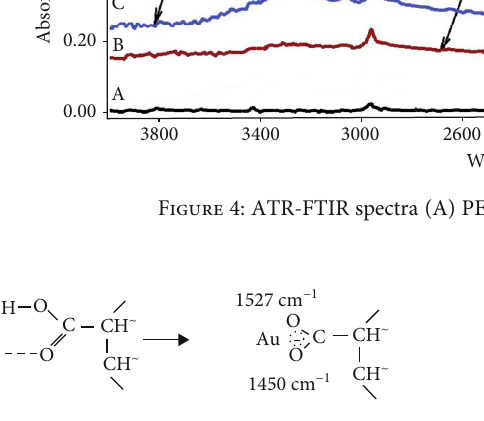
Figure 5: Possible interaction between Au particles and polar groups after activated surface PET fi lm.